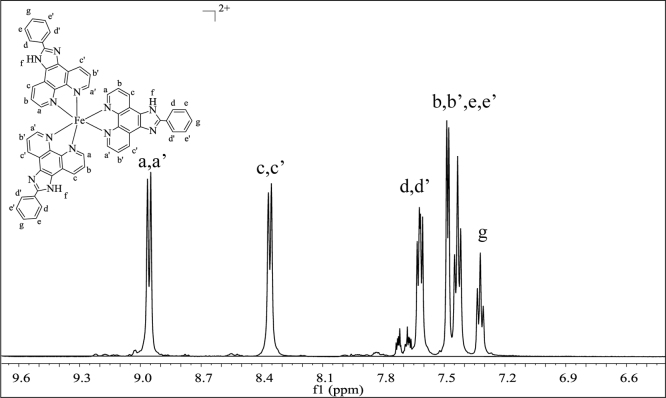
1H NMR spectrum (500 MHz) of complex 4 in dimethylsulfoxide-d6.